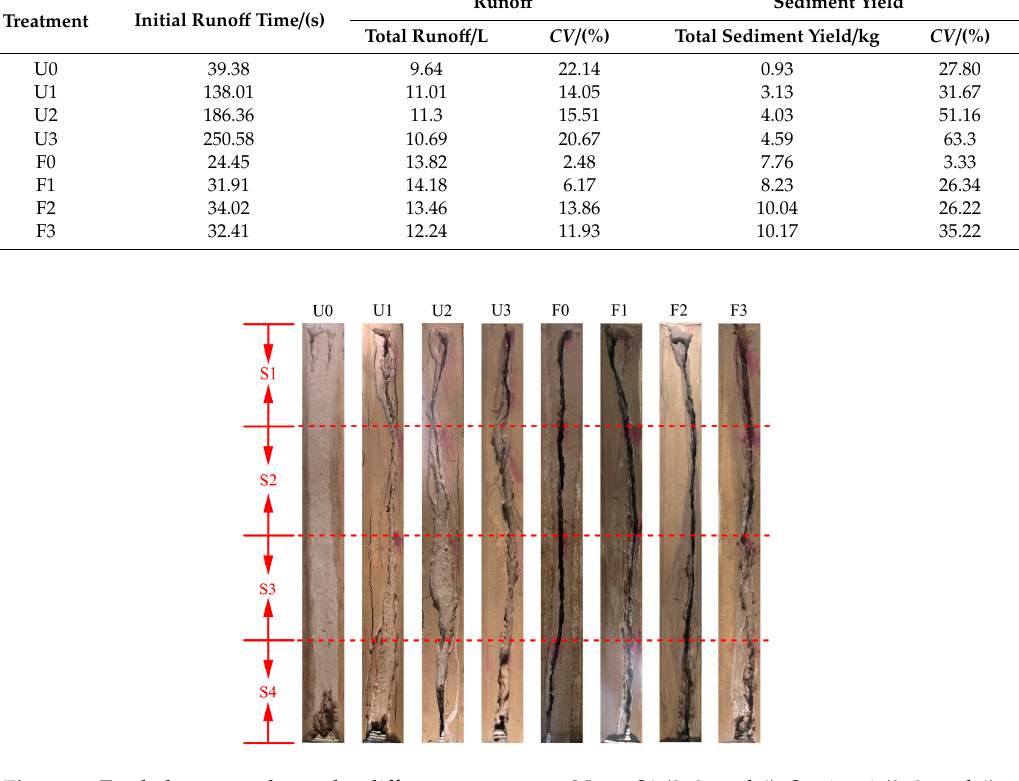
Figure 3. Eroded topography under di ff erent treatments. Note: S1 (2, 3, and 4), Section 1 (2, 3, and 4).